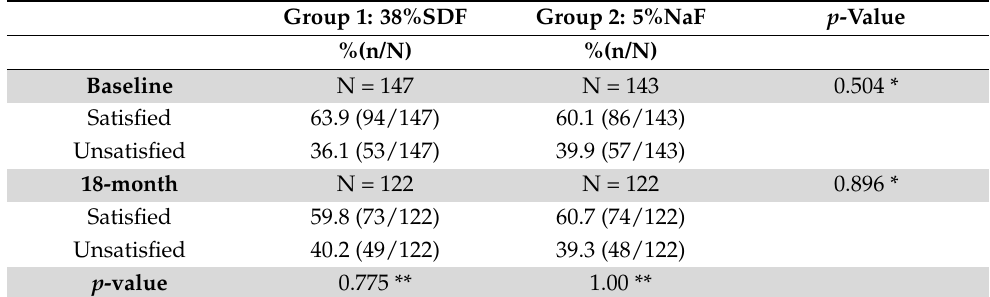
Table 4. Parental satisfaction on their child’s dental appearance at baseline and the 18-month follow-up. Group 1: